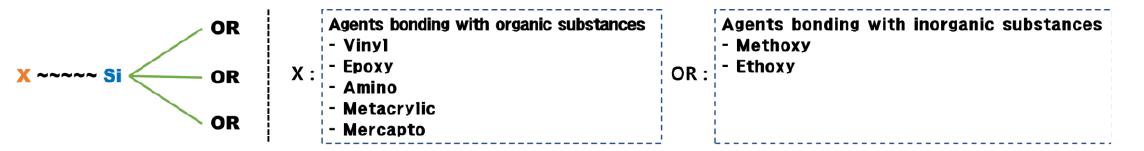
Figure 2. Sealant coupling agent structure.